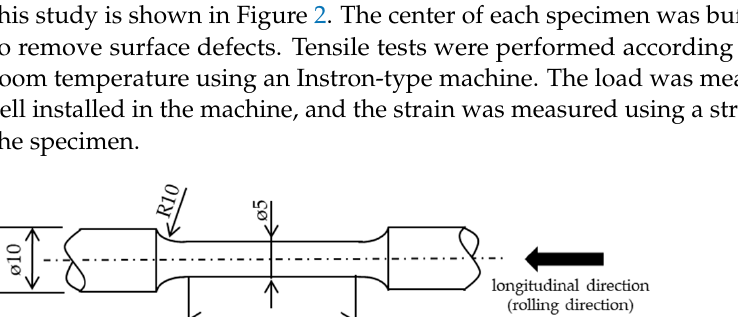
Figure 2. Shape and dimension of tensile and high cycle fatigue test specimen.